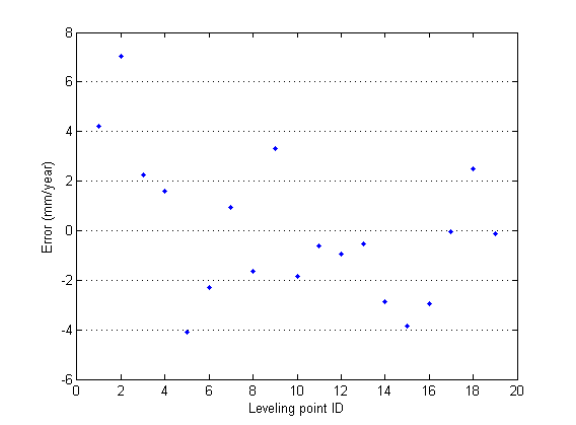
Figure 5. The errors between levelling measurements and InSAR